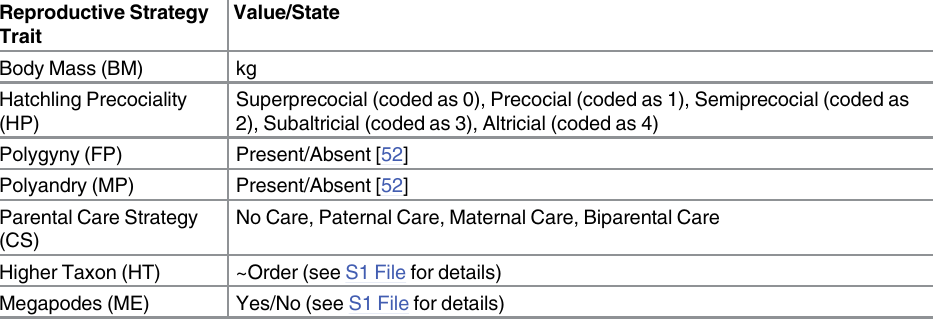
Table 1. Coding of reproductive ecological traits used in these